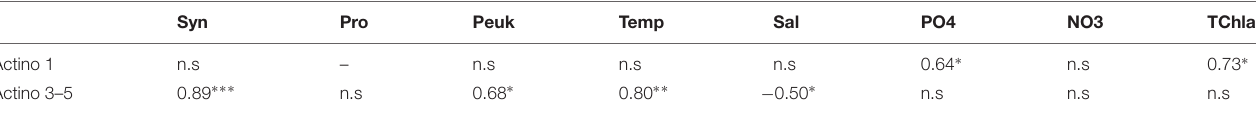
TABLE 3 | Spearman rank correlations between environmental variables and Actinobacteria OTUs dominant at MAR, HNL, and GYR (Actino 3–5) or at UPW (Actino 1).